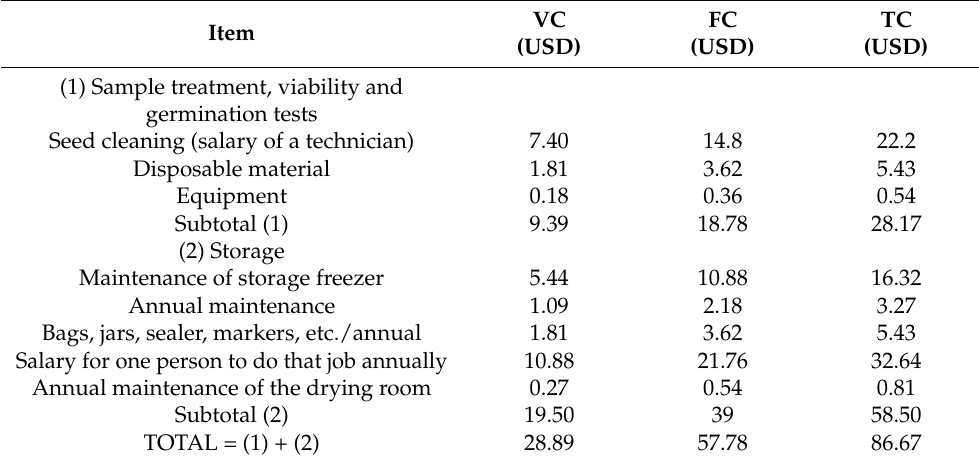
Table 6. Annual cost for the treatment and storage of one accession in a SB.